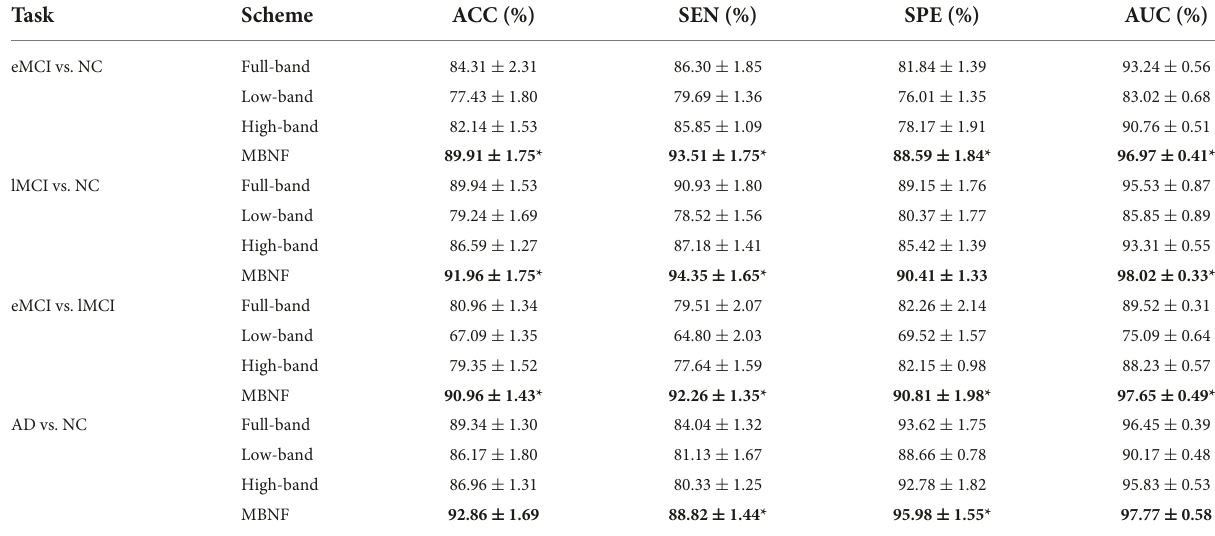
TABLE 3 Classification performance of four schemes in four classification tasks based on sparse representation (SR) construction method (mean ± standard deviation). Task Scheme ACC (%) SEN (%) eMCI vs.